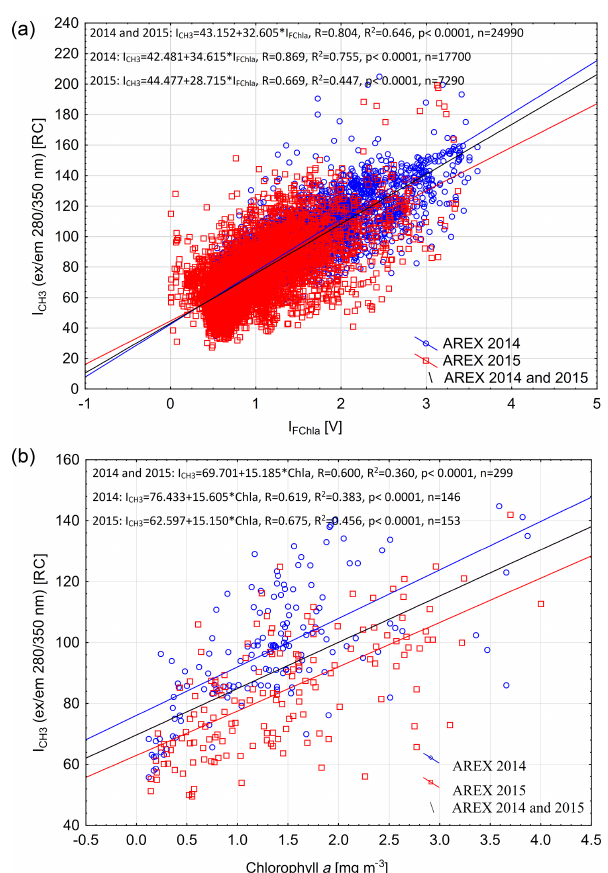
Figure 5. Relationship between chlorophyll a fluorescence ( I F Chla ) and fluorescence of the protein-like component ( I CH3 ) (a) and rela- tionship between fluorescence of the protein-like component ( I CH3 ) and chlorophyll a concentration from discrete water samples (b) in the upper 200m of the water column in 2014 and 2015. Set of lin- ear regression functions, correlation coefficient ( R ), coefficient of determination ( R 2 ), p value, and number of samples ( n ) are pre- sented in Fig.